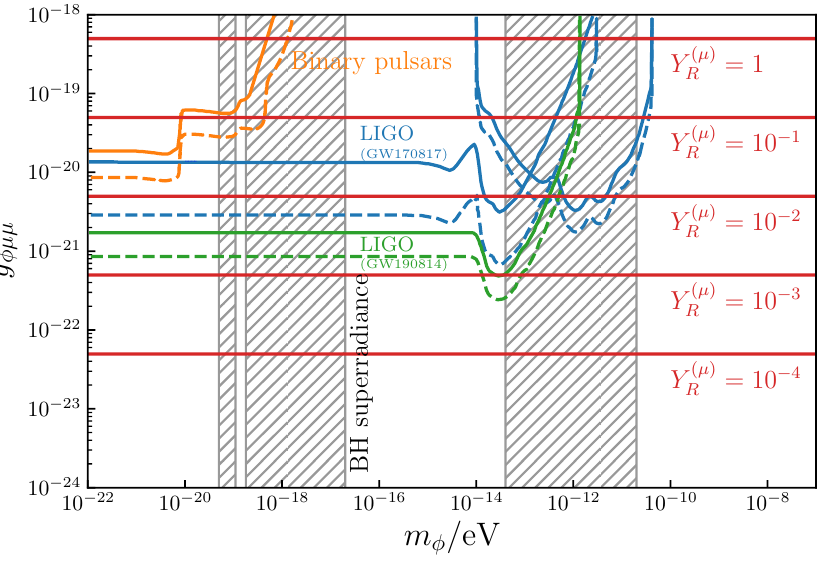
Figure 4 . The e(cid:11)ective Yukawa coupling of (cid:30) to (cid:22) , compared with experimental limits. The predictions of our model (red) are evaluated according to eq. (5.3) with m ( (cid:22) ) (cid:23) = 0 : 03 eV. The muonic force could be probed in binary systems of neutron stars (NS) due to the considerable abundance of muons. The blue and green curves represent current sensitivity of the LIGO observations of GW170817 (NS-NS merger) and GW190814 (NS-BH merger) events, respectively. Solid (dashed) curves take conservative (optimistic) estimates of the muon abundance [24]. In addition,